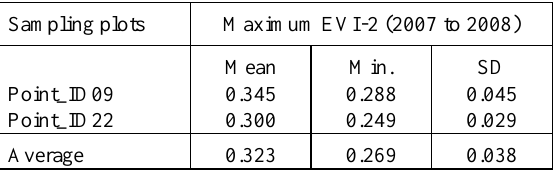
Table 3. Sampling plots of clear cut with EVI-2 values Using this approach, a negative second-order polynomial relation can be described by the mathematical equation y=−α×x 2 +β×x+γ. On the sampling plot scale, the results show a non-linear correlation (R²=0.81, p<0.01 ) between EVI-2 and stand age. Figure 2 shows the relationship between EVI-2 and red pine forest growth.